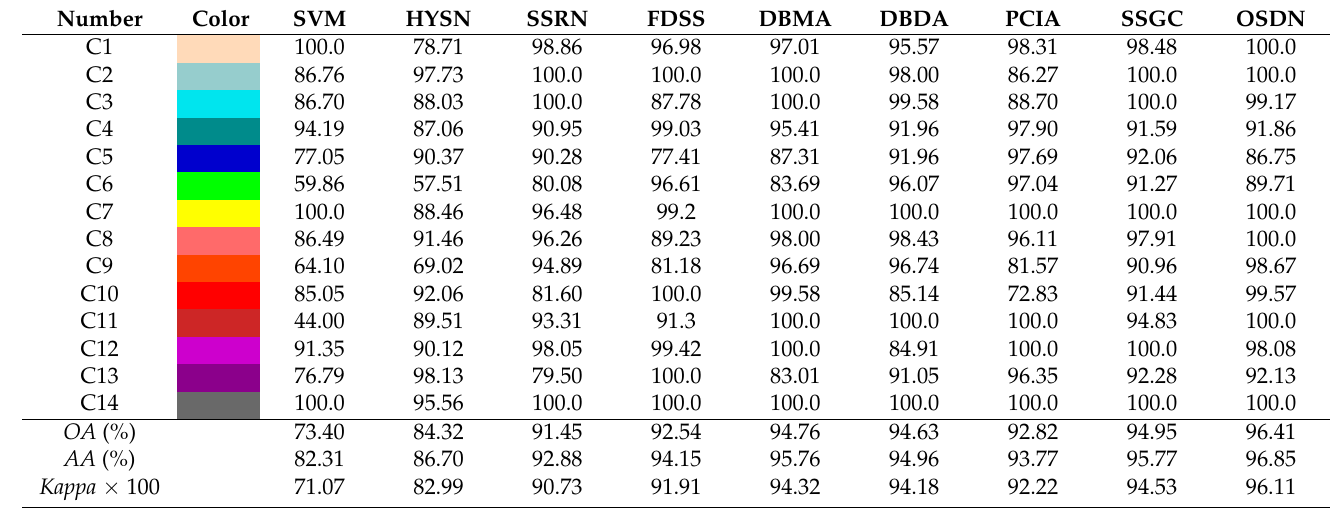
Table 13. Classification results of the BS dataset based on 2% training samples.